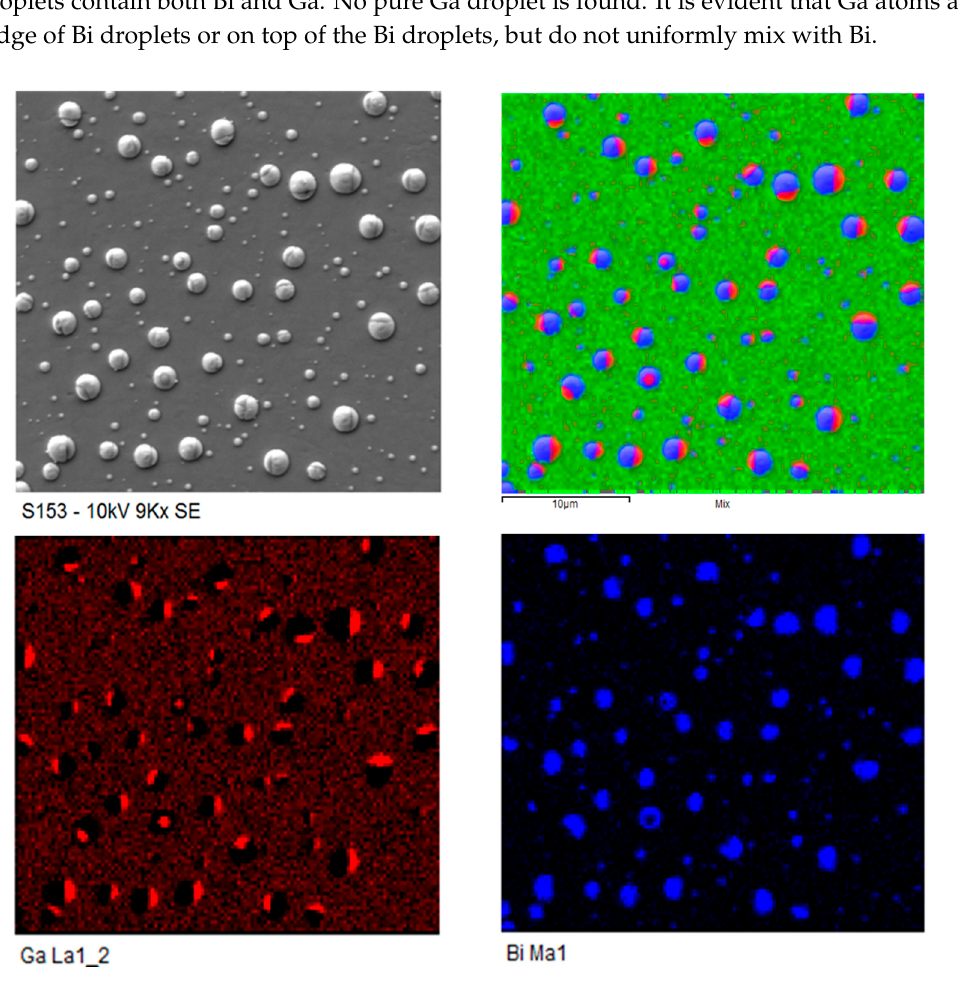
Figure 3. SEM image and EDX mapping of GaSbBi surface droplets.